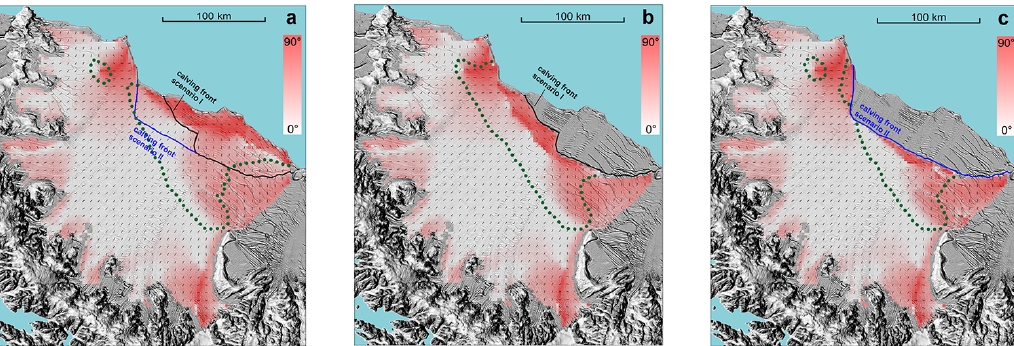
Figure 3. Results from ice shelf flow model: stress-flow angle fields for the present-day ice front geometry (a) and for the new geometries under Scenarios I (b) and II (c) . The green dotted line represents the contour line of zero second principal